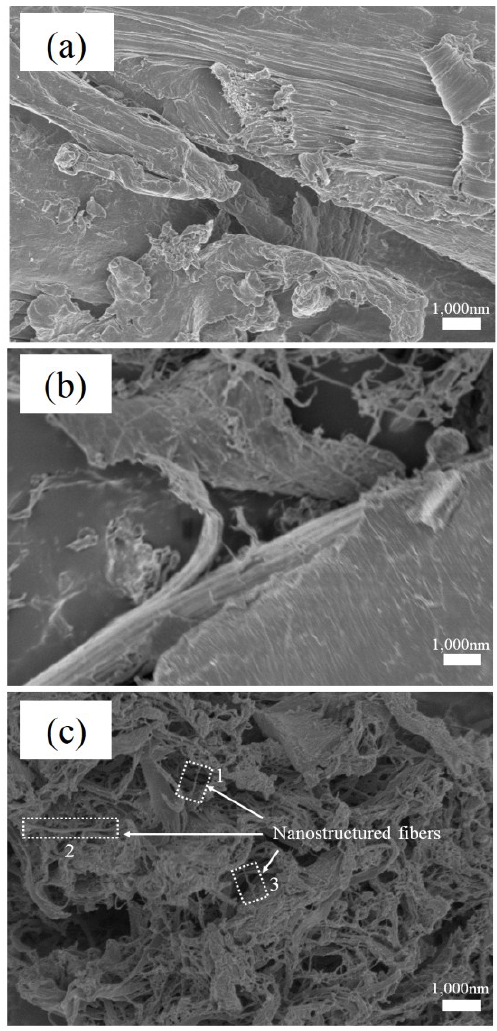
Figure 2. SEM micrographs show the surface morphology of ( a ) untreated WF; ( b ) LCNF (W4); and ( c ) LCNF (W8). Representative nanostructured fibers were enclosed by dotted frame. The diameter of each nanostructured fibers are approximately (1) 66.4 nm, (2) 97.9 nm, and (3) 87.4 nm,